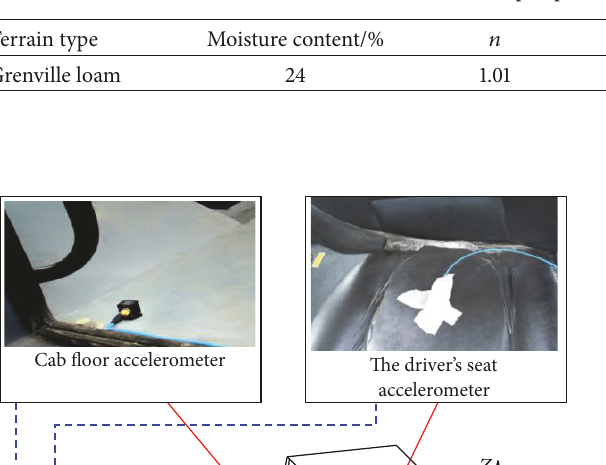
Table 4: The lumped parameters of the Grenville loam.